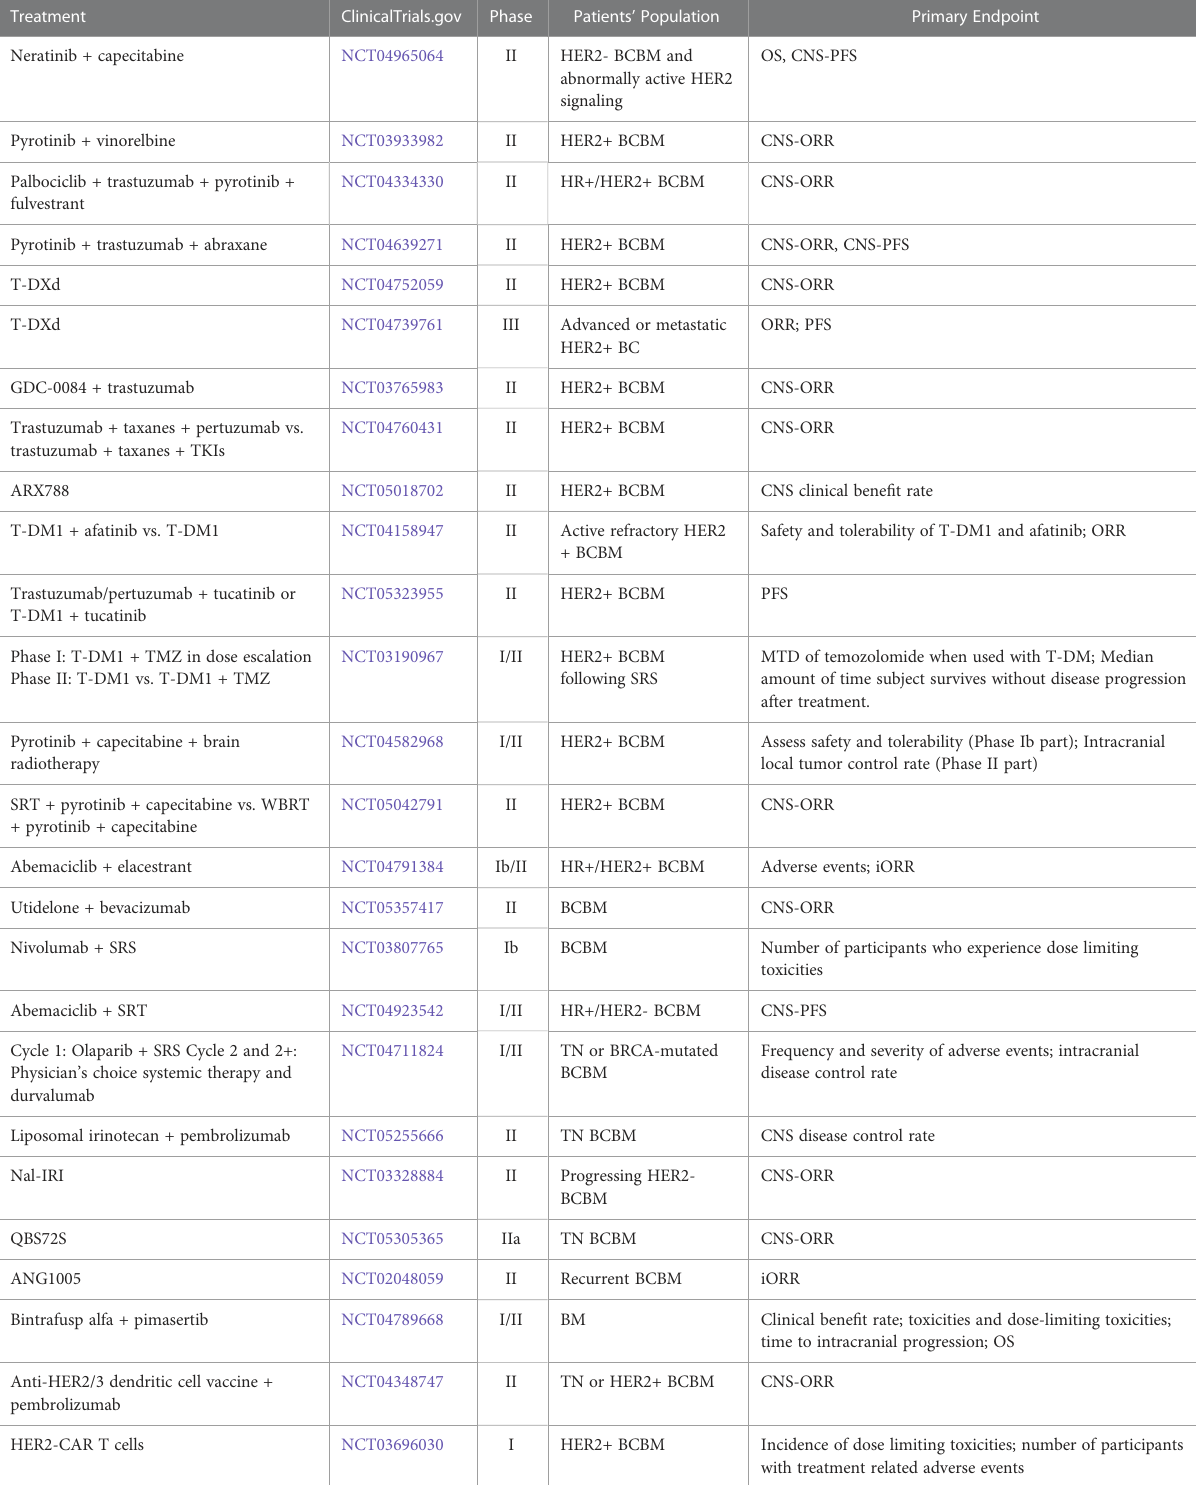
TABLE 3 Ongoing clinical trials for metastatic breast cancer with brain